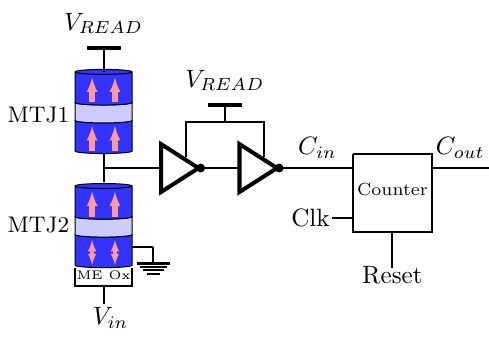
Figure 15. ADC proposed in Reference